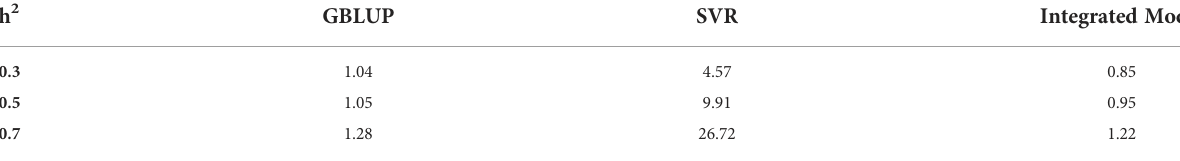
TABLE 4 Error variance for different GS models at different heritability using k-RCV.